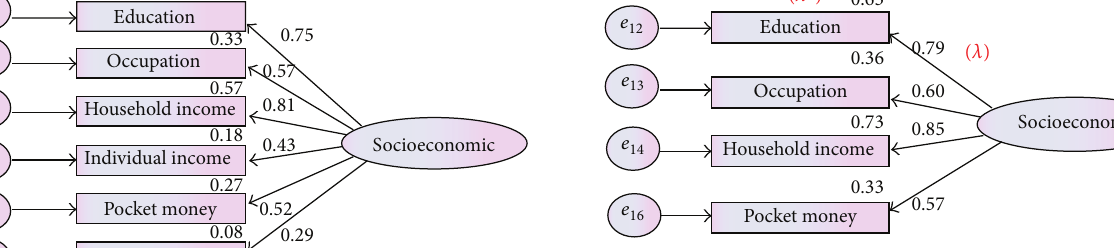
Figure 2: Modified measurement model for socioeconomic factors. Table 3: Factor loading for Parental feeding practice.